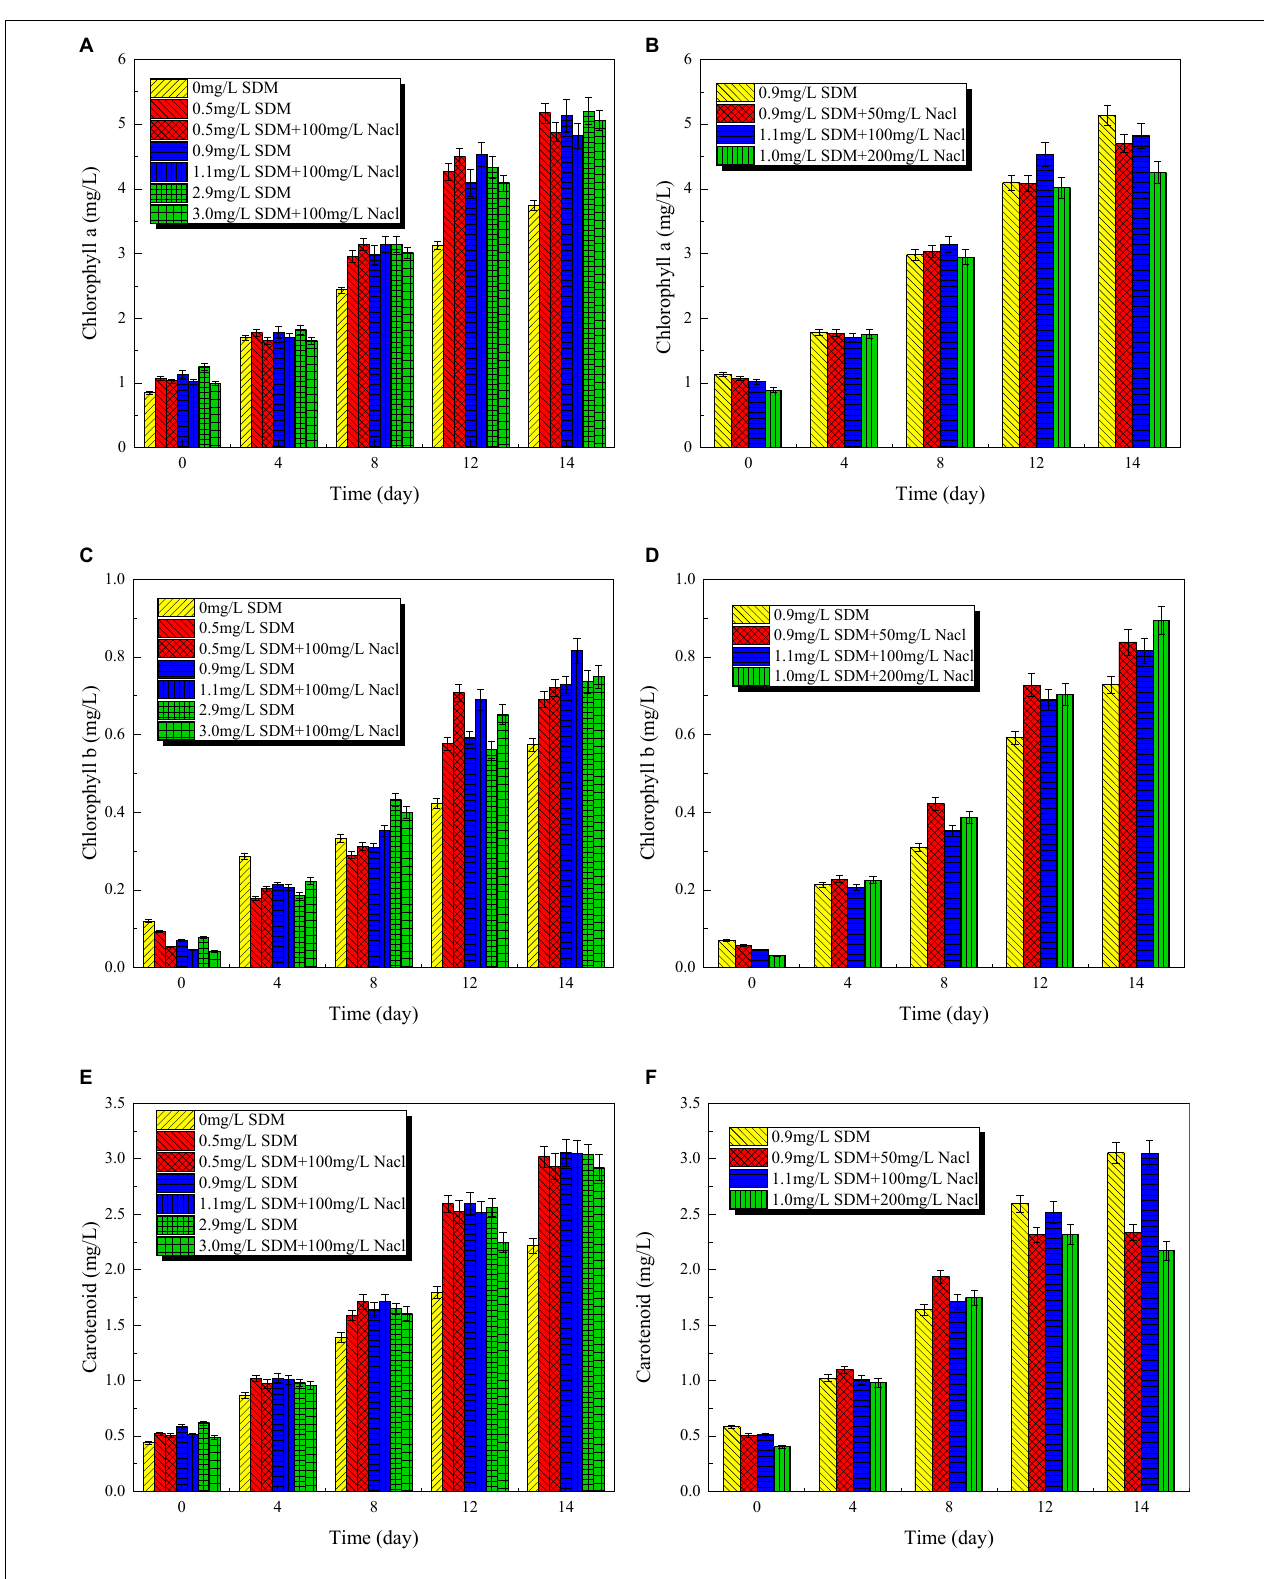
FIGURE 5 | Chlorophyll a (A,B) , b (C,D) , and carotenoid (E,F) content variation of Chlorella sp. L38 and Phaeodactylum tricornutum MASCC-0025 under different SDM concentrations.